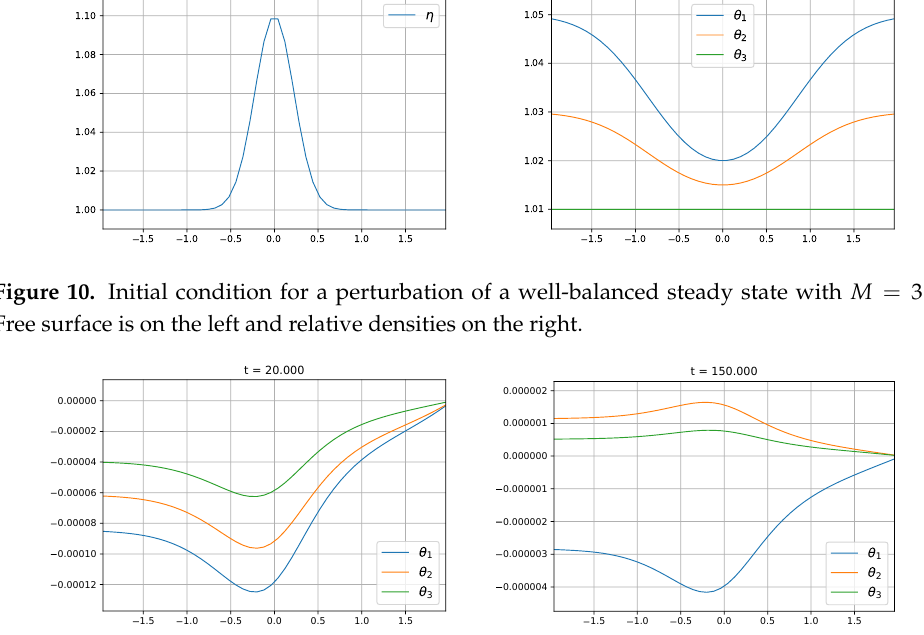
Figure 11. Difference on the relative density between the perturbed and unperturbed steady state.